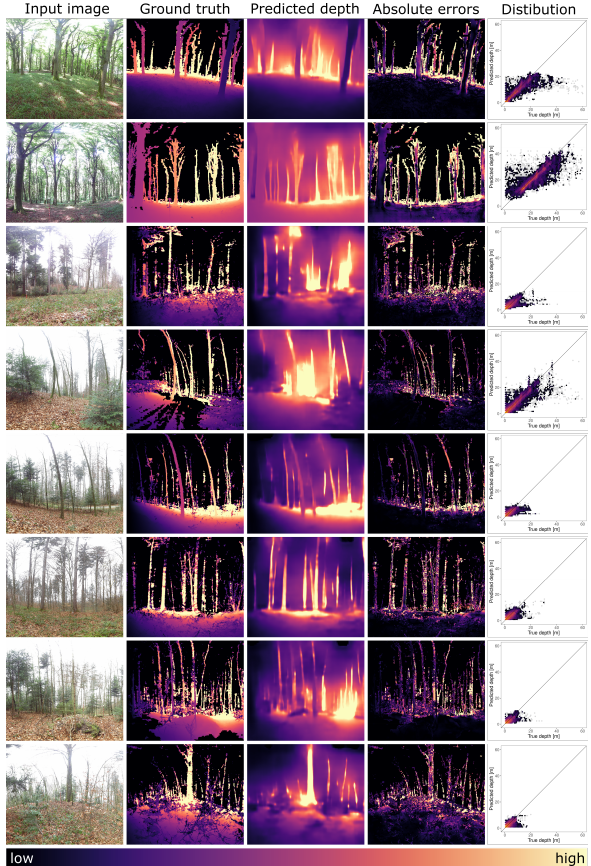
Figure 7. Absolute error (in m) between our predicted depth and the ground-truth depth. Purple areas in columns two and three signify image parts (including trees) close to the camera, whereas yellow areas illustrate more distant image objects. For the fourth column, yellow areas represent absolute errors close to 3 m, whereas black and purple areas signify small absolute errors close to 0 m. The last column shows the joint distribution of predicted depth and ground-truth depth, with yellow and orange points indicating the highest